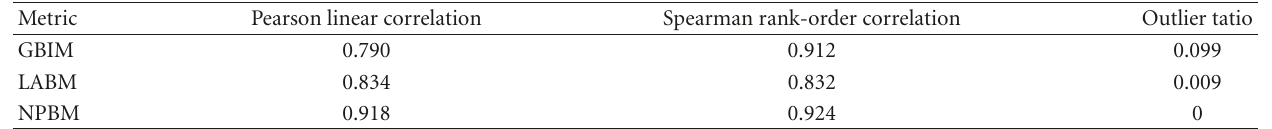
Figure 11: Illustration of how to evaluate the e ff ect of a grid detector on a blockiness metric: an image patch showing visible blocking artifacts was upscaled with a scaling factor 4 / 3 × 7 / 3, and the metrics NPBM, GBIM, and LABM were applied to assess the blocking annoyance of the scaled image. Table 1: Performance comparison of three blockiness metrics.